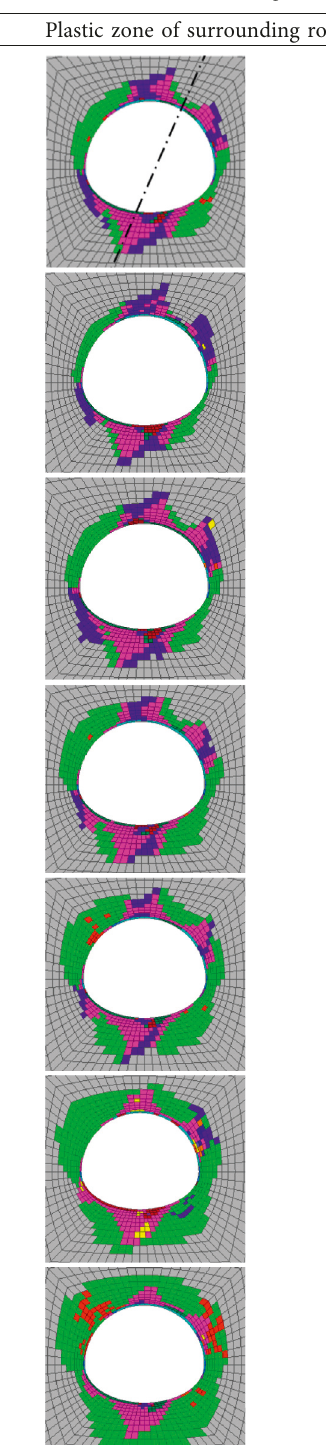
Table 4: The effect on the plastic zone under the ω conditions at an inclination angle of 30 °